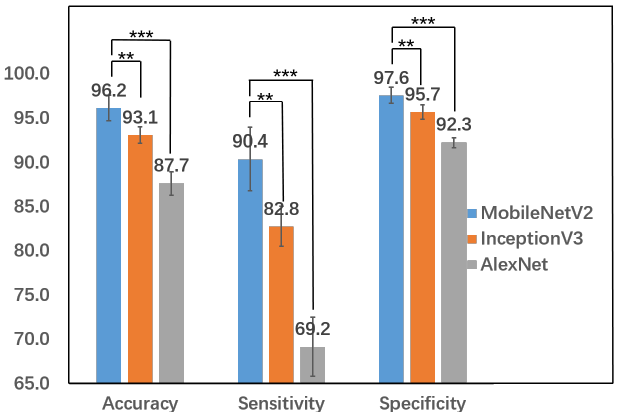
Figure 4. The performance comparison using the t -test for the three approaches on five independent runs. **: significant at p -value 0.01. ***: significant at p -value